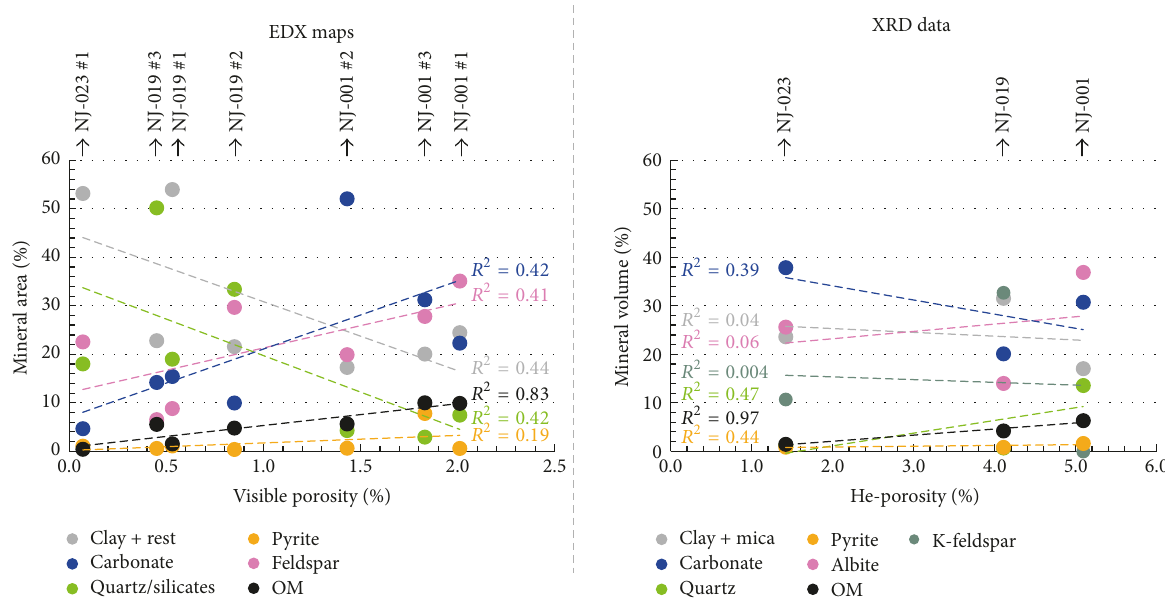
Figure 14: Comparison of EDX and XRD (plus TOC) data in regard to the correlation of mineral phases and porosity. Only OM reveals a clear trend with porosity, both, independently of applying direct (EDX) versus indirect (XRD plus TOC) types of